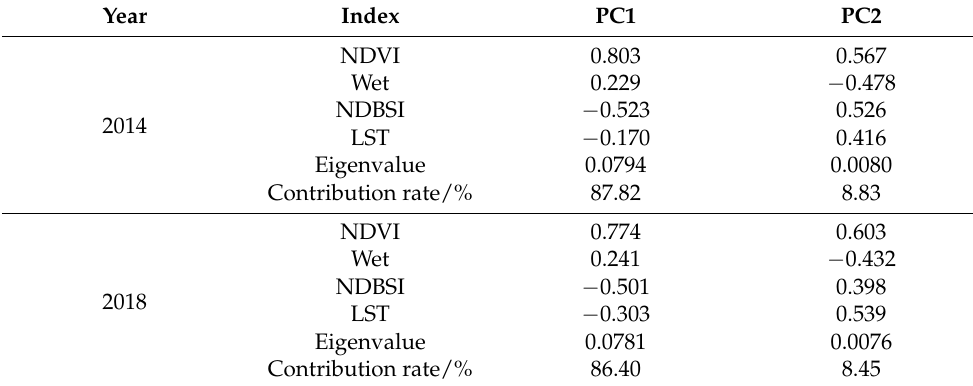
Table 2. Principal component analysis (PCA)